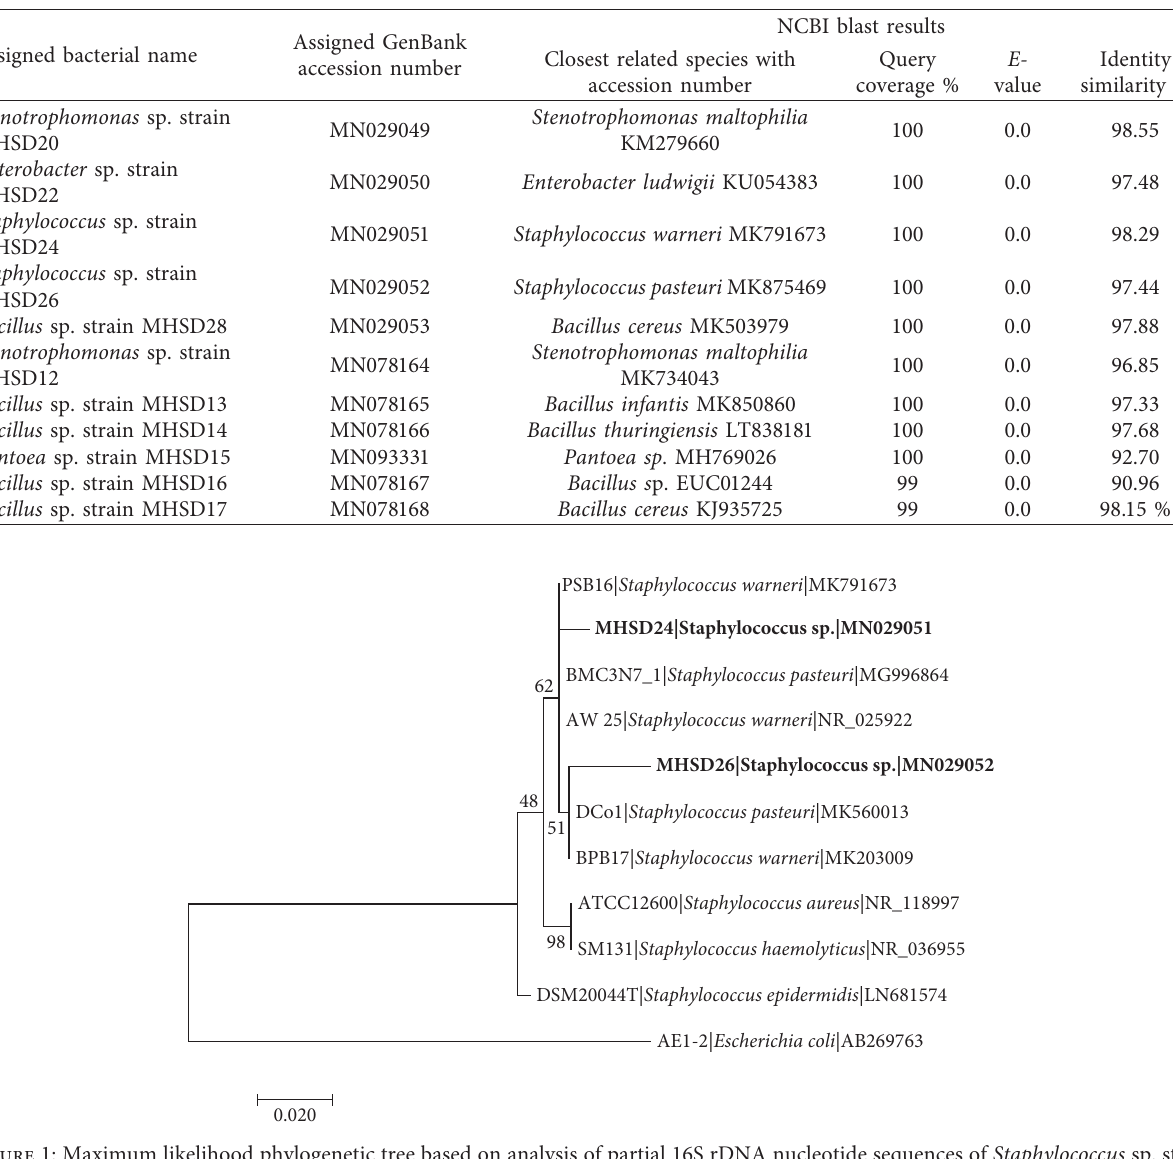
Table 2: NCBI BLAST 16S rRNA gene sequences of bacterial endophytes isolated from Dicoma anomala .